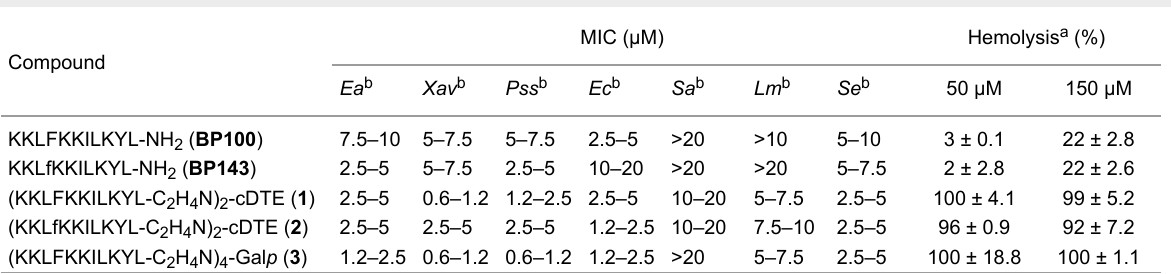
Table 1: Antibacterial activity (MIC) and cytotoxicity of parent peptides and carbopeptides.